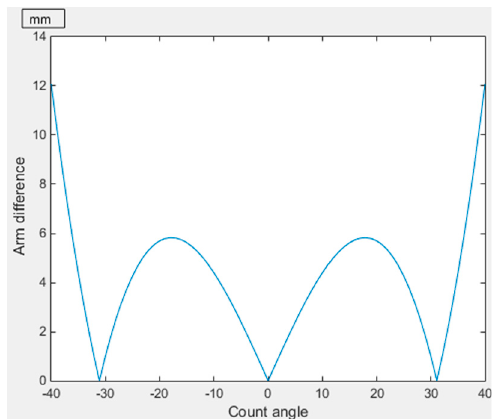
Figure 6. Curve of the stroke difference of a cylinder with steering angle.